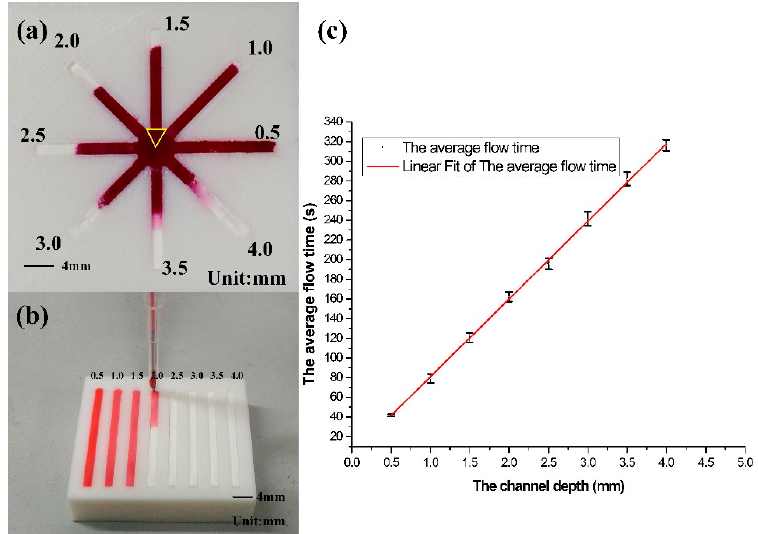
Figure 6. Relationship between channel depth and flow time: ( a ) The flow trend of red dye in 8